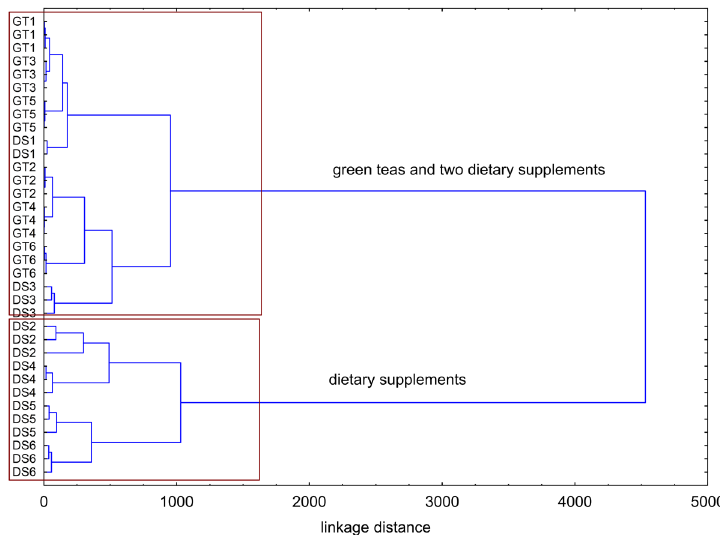
Figure 2. The dendrogram obtained by hierarchical cluster analysis using Ward’s method and squared Euclidean distance